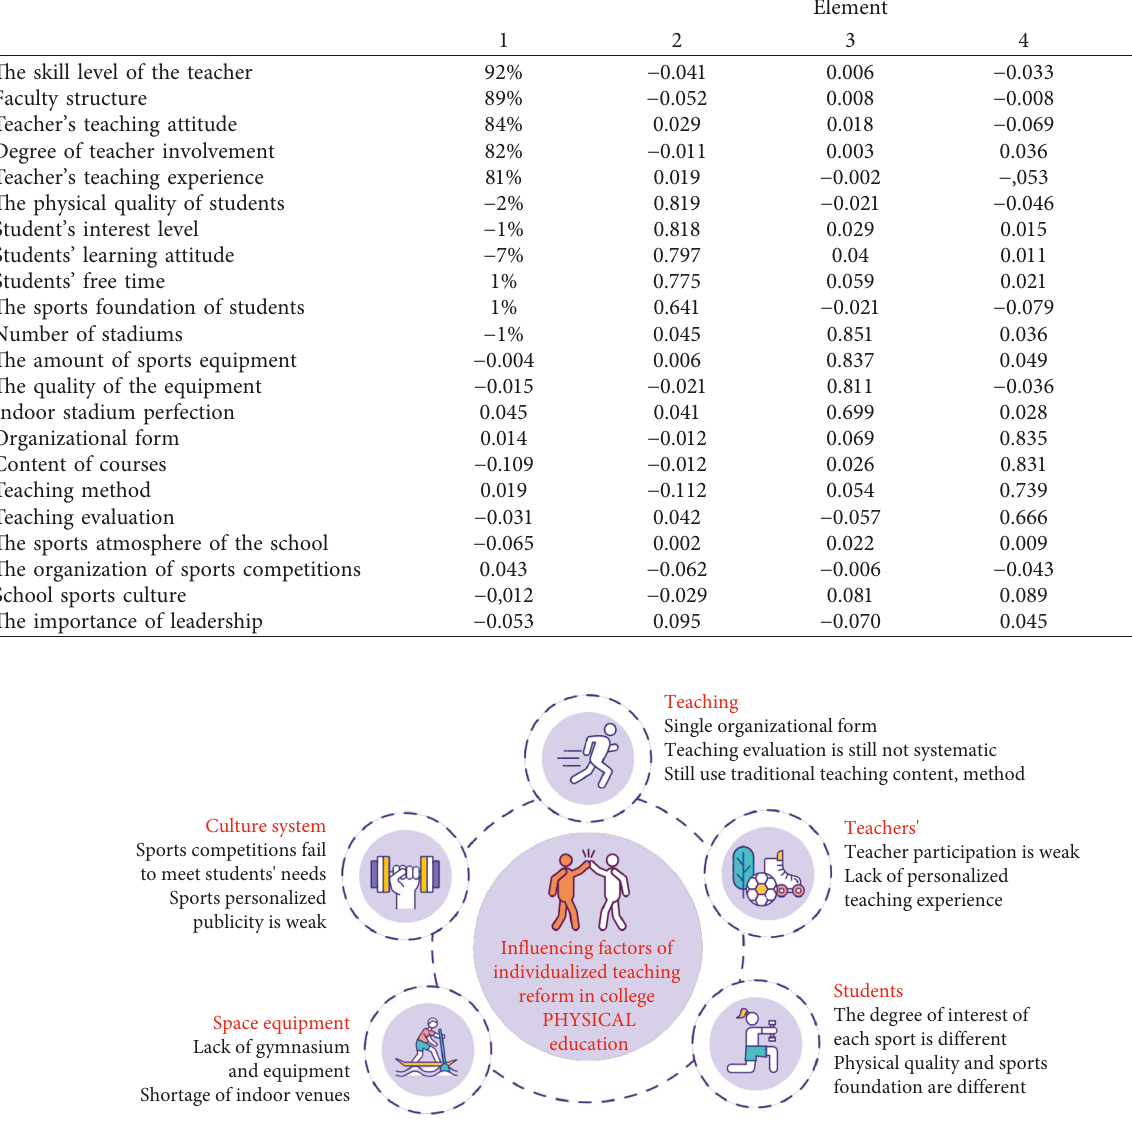
Figure 5: Factors influencing personalized teaching of college PHYSICAL